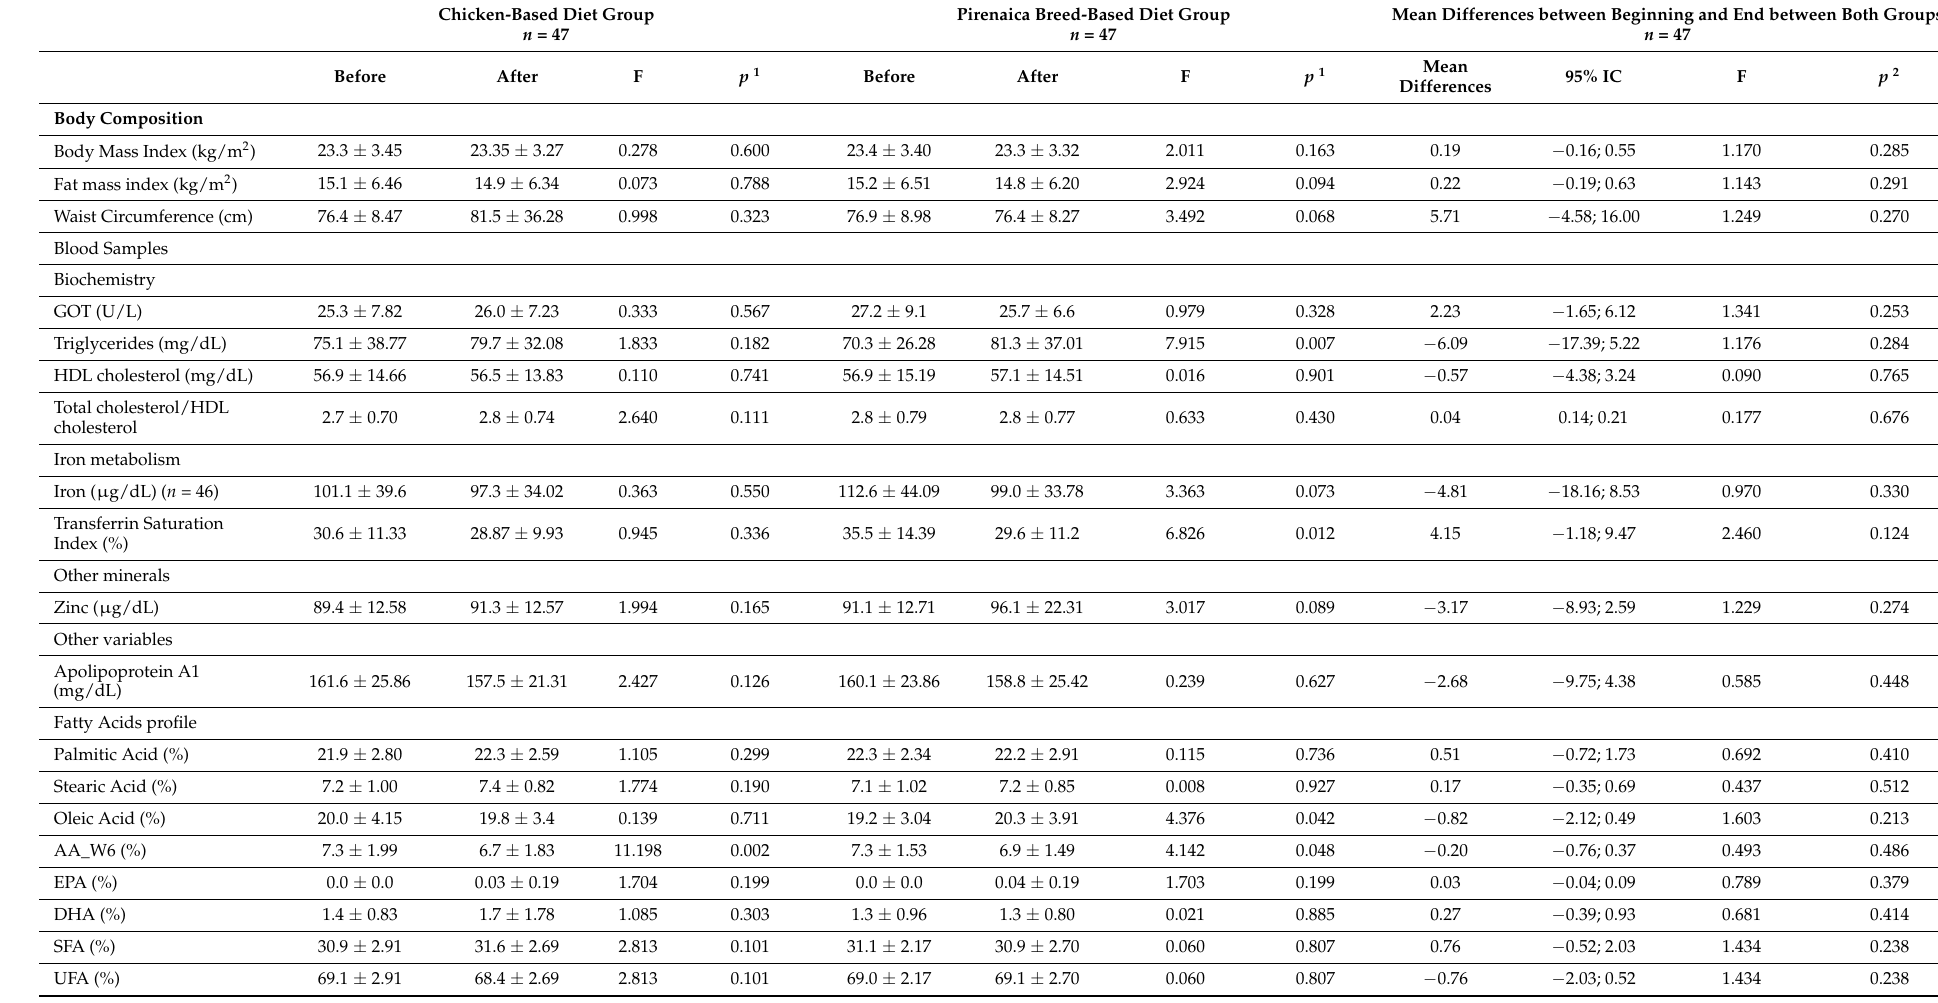
Table 3. Mean values of body composition and blood parameters by intervention and control group: before, after, and mean differences over time between both groups ( n = 47). Chicken-Based Diet Group Pirenaica Breed-Based Diet Group Mean Differences between Beginning and End between Both Groups n = 47 n = 47 n = 47 Before After F p 1 Before After F p 1 Mean Differences 95% IC F p